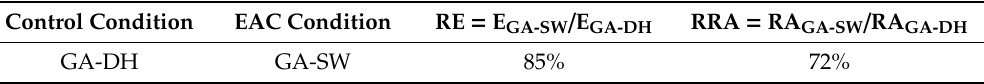
Table 8. Embrittlement susceptibility ratios for the GA-SW condition.